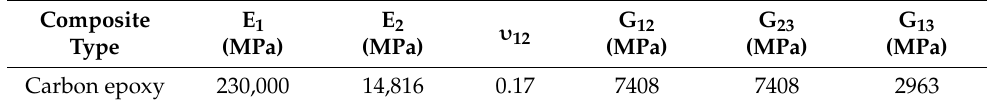
Table 3. Properties of FRP composite material .